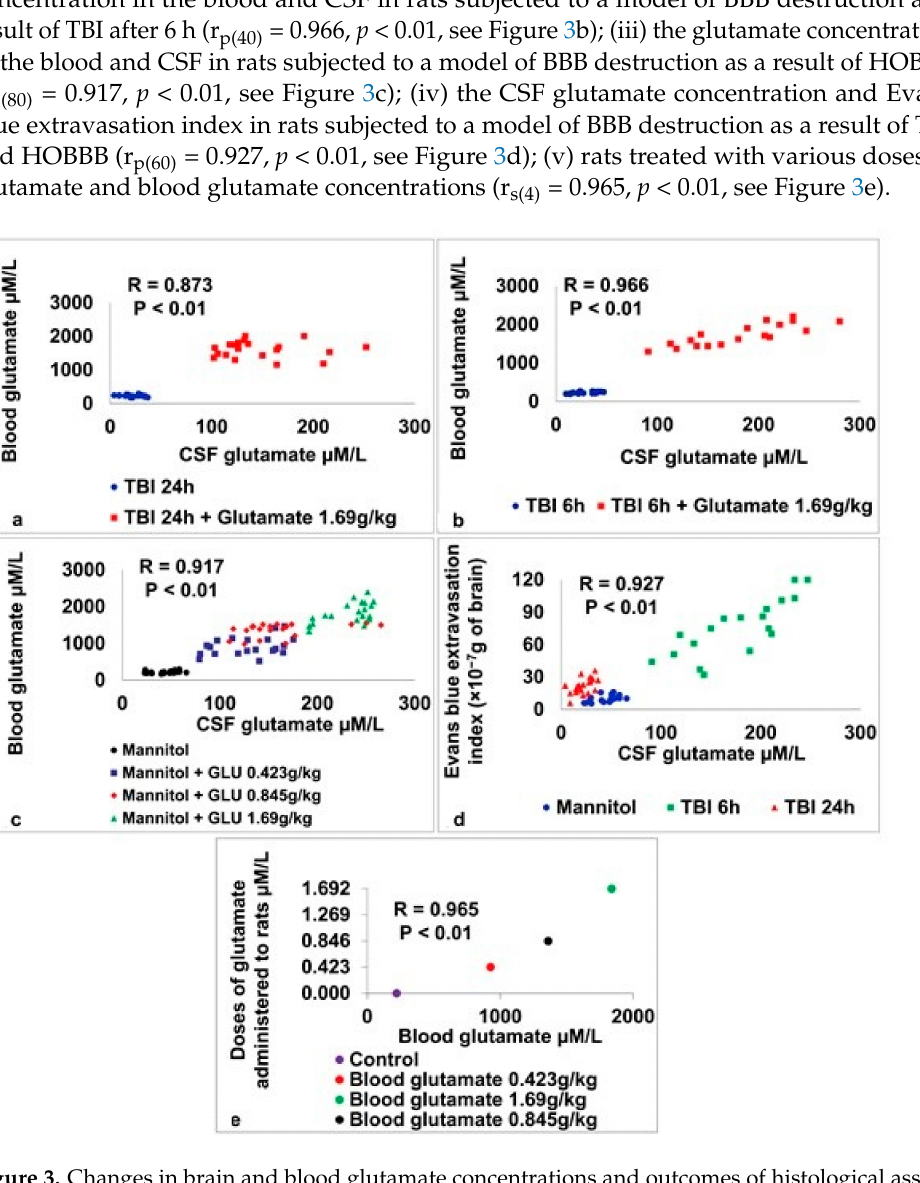
Figure 3. Changes in brain and blood glutamate concentrations and outcomes of histological assess- ments of BBB breakdown in study groups compared to control